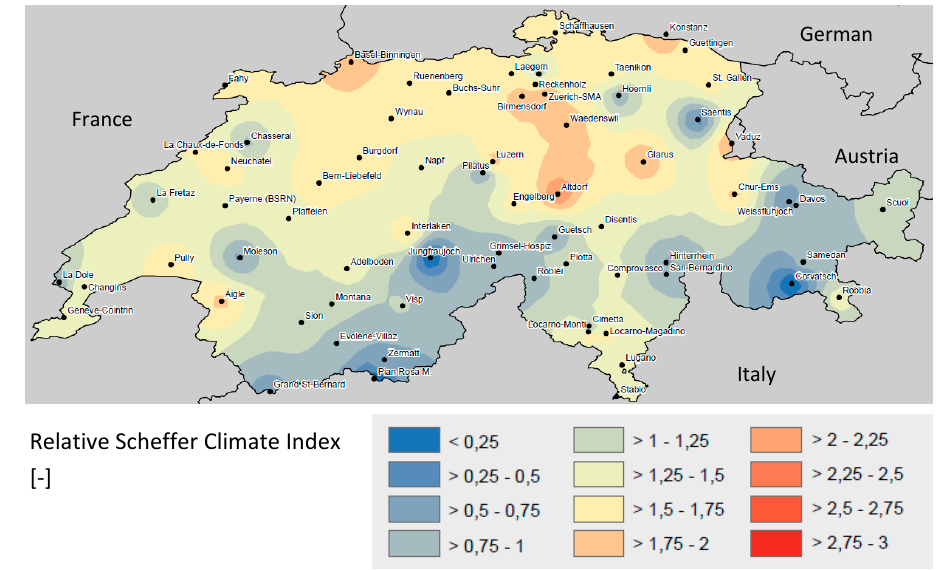
Figure 3. Relative Scheffer Climate Index (SCI), reference location: Uppsala, Sweden, SCI (Uppsala) = 46.3. The variation of the site-specific and climate-induced decay hazard in Switzerland became also evident from mapping the annual temperature- and moisture-induced dose which is illustrated in Figure 4 for different combinations of exposure and decay models.